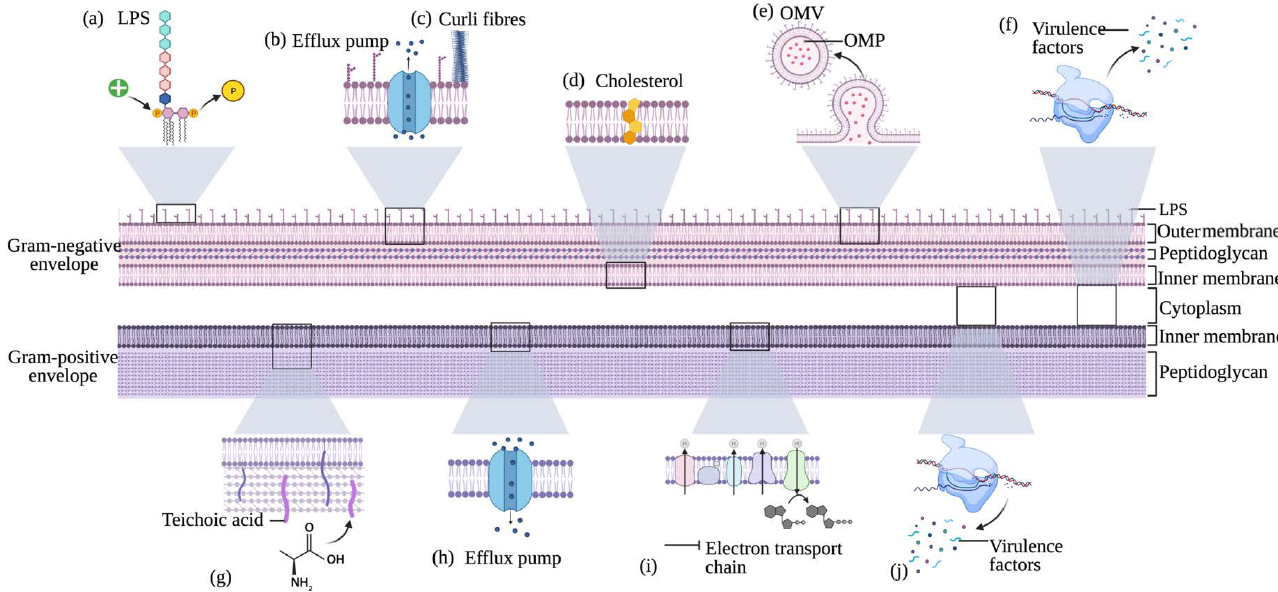
Figure 1. Schematic presenting examples of major cellular resistance mechanisms seen in Gram-negative and Gram-positive bacteria that work to decrease its susceptibility to LL-37. Mechanisms ( a – f ) are specific to the Gram-negative bacterial envelope. ( a ) LPS modifications as an example of cell membrane and charge modifications that occur in the outer membrane, ( b ) efflux pumps, ( c ) curli production, ( d ) cholesterol as an example of the incorporation of exogenous molecules into the membrane, ( e ) the formation of outer membrane vesicles (OMVs) with outer membrane proteins (OMPs) as an example of a component that may be transported via OMVs, and ( f ) the upregulation of virulence factors that occur in the cytoplasm. Mechanisms ( g – j ) are specific to the Gram-positive envelope. ( g ) D-alanination of teichoic acid as an example of cell membrane and charge modifications that occur in the inner membrane, ( h ) efflux pumps, ( i ) inhibition of the electron chain (ETC) as an example of a metabolic change in the cell, and ( j ) the upregulation of virulence factor expression that occur in the